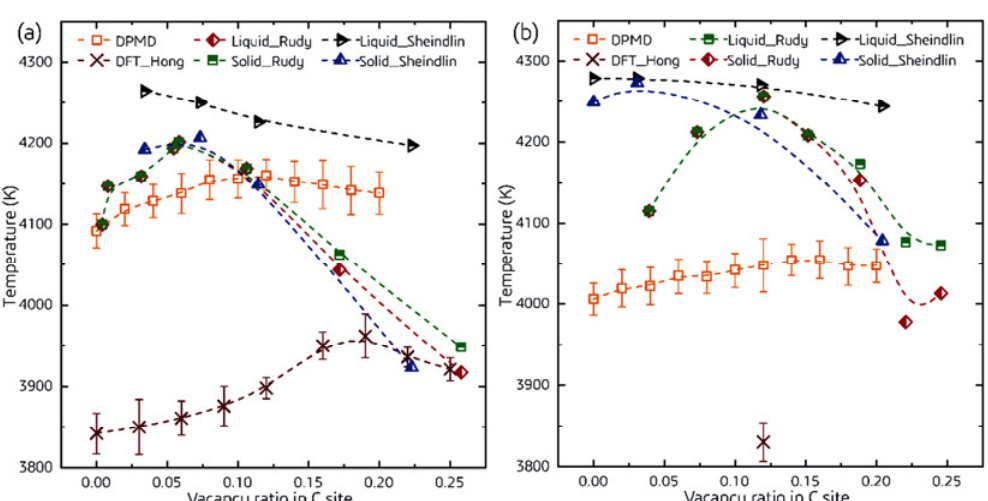
Fig. 4 Comparison of calculated and measured melting points of (a) HfC 1 − x and (b) TaC 1 − x . DPMD represents the results calculated in this work. DFT_Hong means the results calculated by Hong and van de Walle [20] using DFT. Liquid_Rudy and Solid_Rudy, and Liquid_Sheindlin and Solid_Sheindlin are the experimental liquid and solid lines of phase diagrams measured by Rudy and Harmon [16–18] and Sheindlin et al . [44],